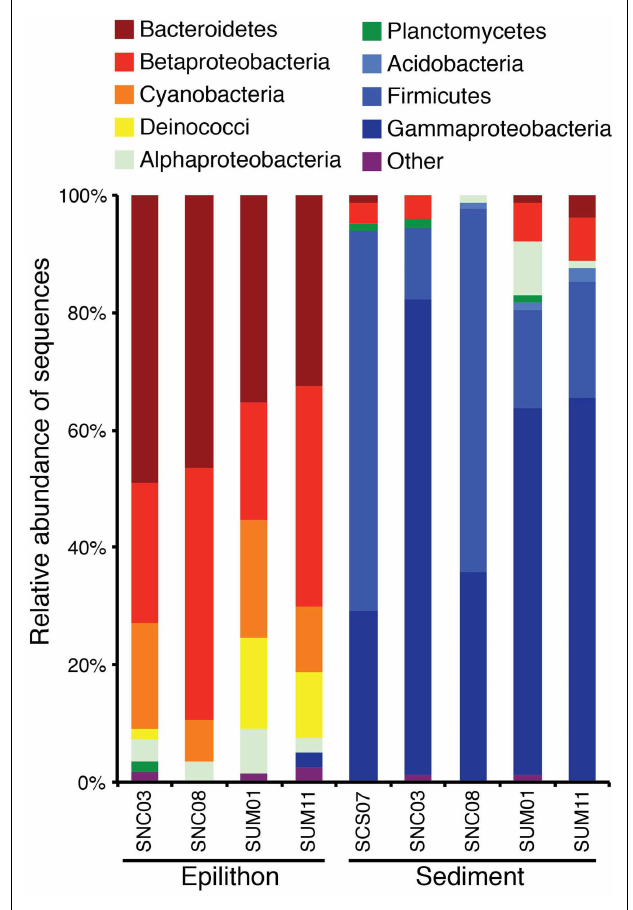
FIGURE 5 | Phylogenetic composition of clone sequences from stream epilithon and sediment samples in the non-carbonate (SNC), complex sedimentary (SCS), and ultramafic (SUM) lithologies expressed as relative abundance within each